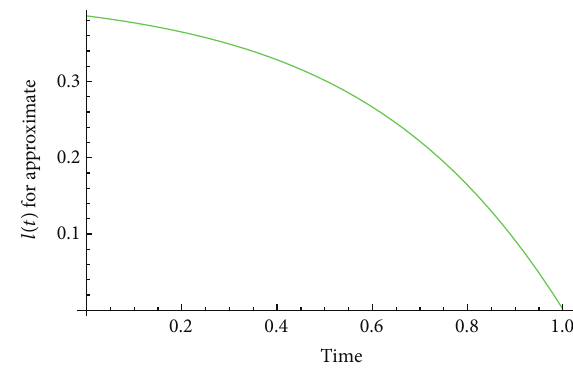
Figure 1: Approximated